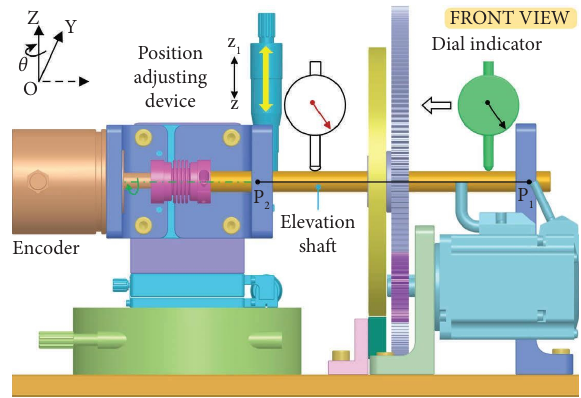
Figure 9: Te elevation shaft is adjusted in the direction of the Z axis.